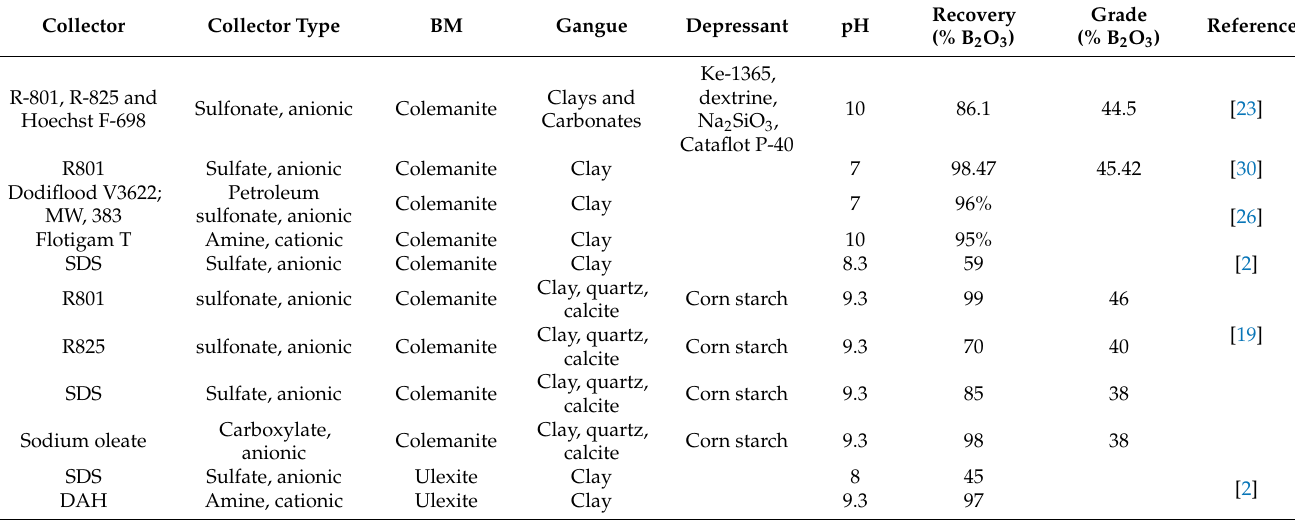
Table 5. Conditions used for the direct flotation separation of boron